Question: Briefly state, in one sentence, what is plotted here.
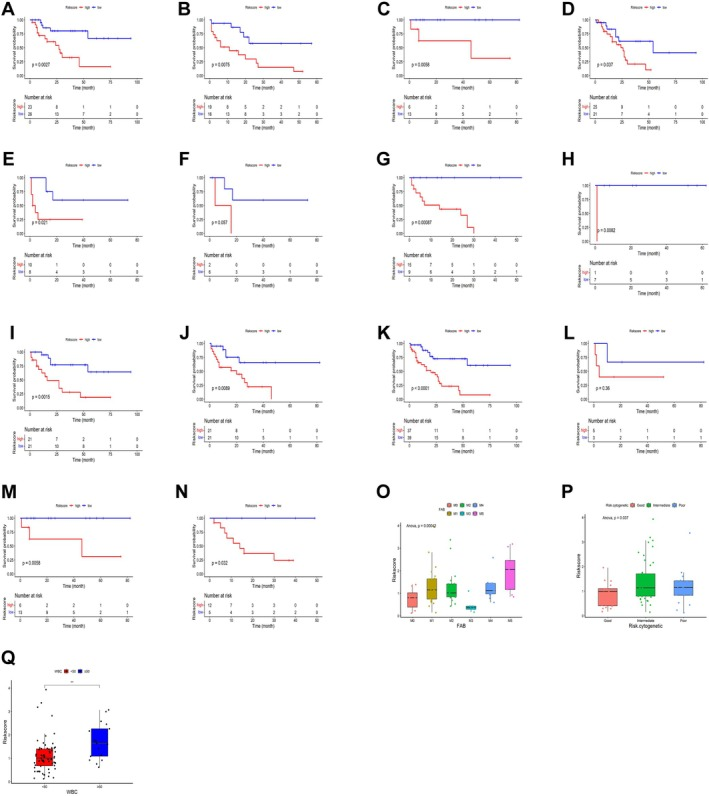
Answer: Association of clinical characteristics with overall survival and their distribution in the train set. (A–N) Kaplan–Meier analyses of OS according to clinical characteristics in the train set. Patients were stratified by age (< 60 [A] vs. ≥ 60 years [B]); risk cytogenetic (good [C], intermediate [D], poor [E]); FAB subtype (M0 [F], M1 [G], M3 [H]); gender (male [I], female [J]); prior malignancy (no [K], yes [L]); and WBC count (< 50 [M] vs. ≥ 50 [N]). Survival differences were assessed using the log‐rank test. (O–Q) Distribution of clinical variables and risk score across patient groups. (O) Boxplot of risk score across FAB subtypes. (P) Risk score distribution among risk cytogenetic categories. (Q) Comparison of WBC levels between groups. Statistical significance was assessed using nonparametric tests, with p ‐values indicated. These analyses further illustrate the relationships between clinical features, risk stratification, and patient prognosis in AML. FAB, French–American–British classification; OS, overall survival; WBC, white blood cell.